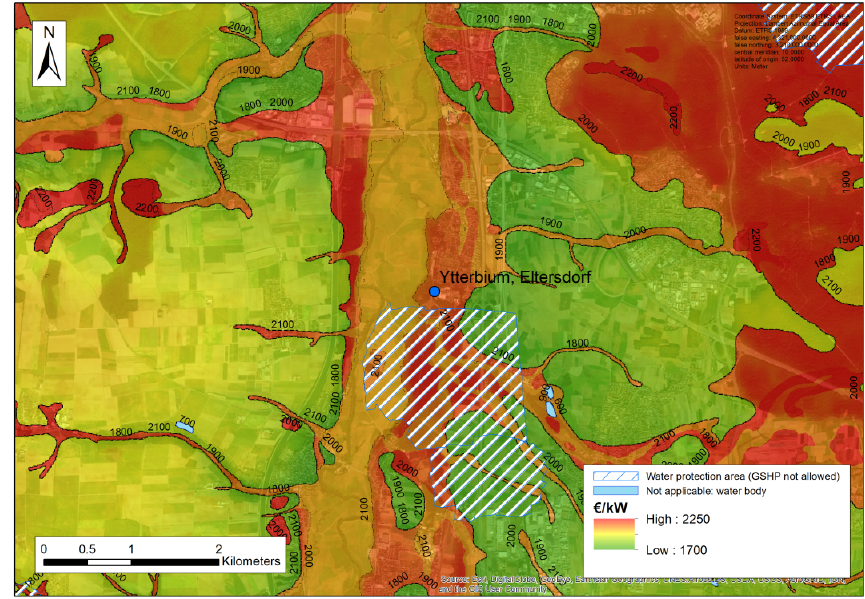
Figure 3. The EURkW − 1 map for double-U heat exchanger systems at Erlangen, Germany (from Perego et al.,